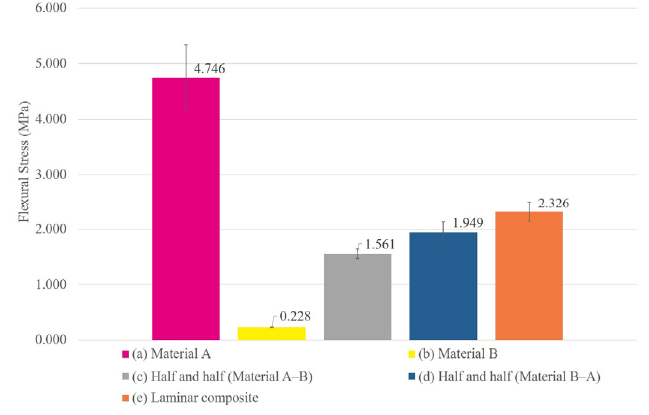
Figure 12. Average flexural stress at 5% strain.